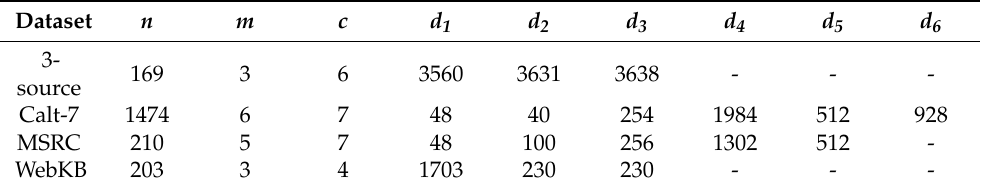
Table 1. Overview of four benchmark datasets.